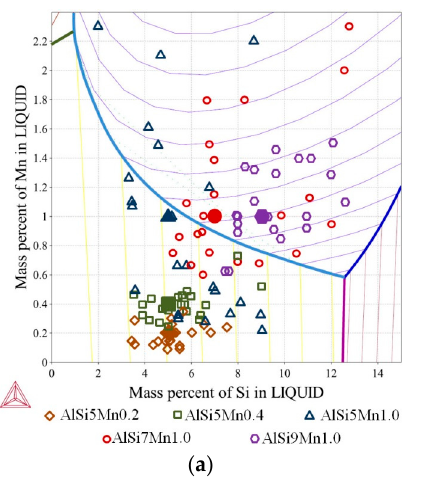
Figure 5. Ternary phase diagram—Al-Si-Mn system: ( a ) liquidus projection with marked chemical compositions measured on the specimens in selected twenty-two points (as on Figure 3b); ( b ) liquidus projection with marked solidification paths (Scheil-Gulliver solidification).